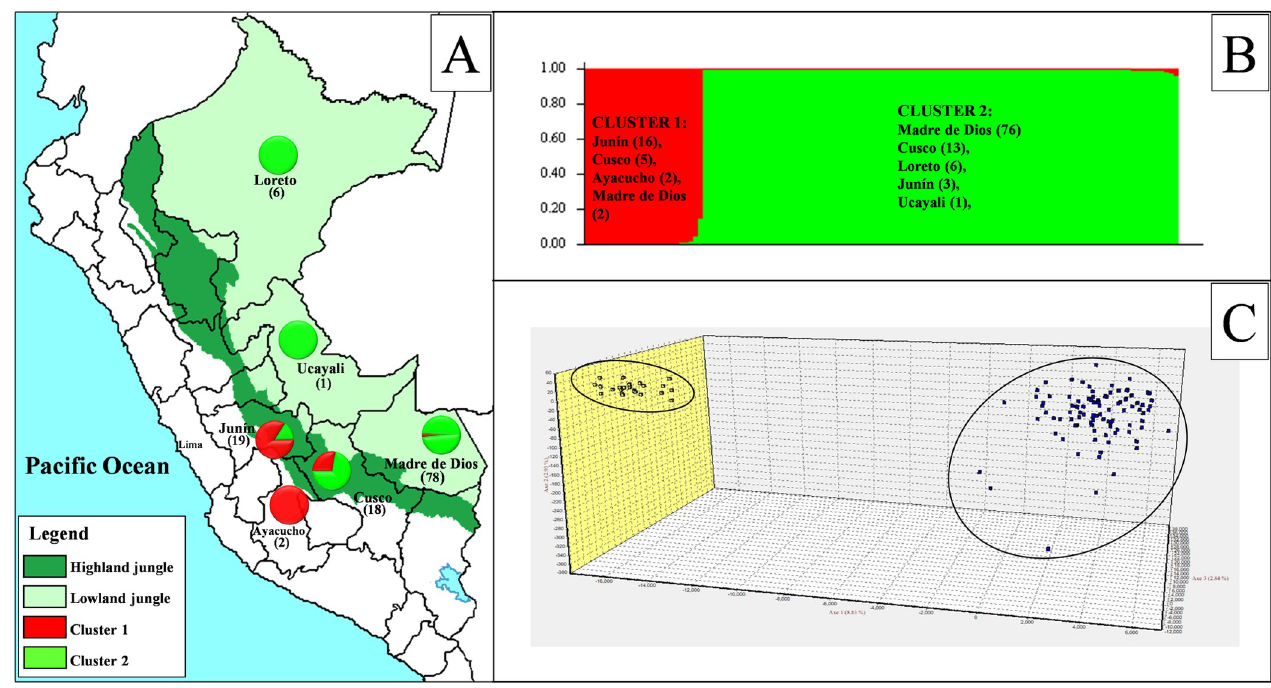
Fig 2. Presence of two L . (V . ) braziliensis genetic clusters from the Peruvian jungle. ( A) Map of Peru showing the geographical ecoregions where the highland jungle in dark green is represented by samples from the departments of Junı´n, Cusco, and Ayacucho, and lowland jungle in light green includes samples from Loreto, Ucayali, and Madre de Dios. The pie charts describe the distribution of the two subpopulations inferred where Cluster 1 is in red and Cluster 2 is in green. (The map is based on a public map downloaded from https://d-maps.com/carte.php?num_car=4765&lang=en). (B) Graphic of STRUCTURE v2.3 analysis showing the number of strains isolated by each department with 25 strains for Cluster 1 and 99 strains for Cluster 2. (C) Factorial correspondence analysis (FCA) plot where 25 yellow squares correspond to strains of cluster 1 and 99 dark blue squares represent Cluster 2.